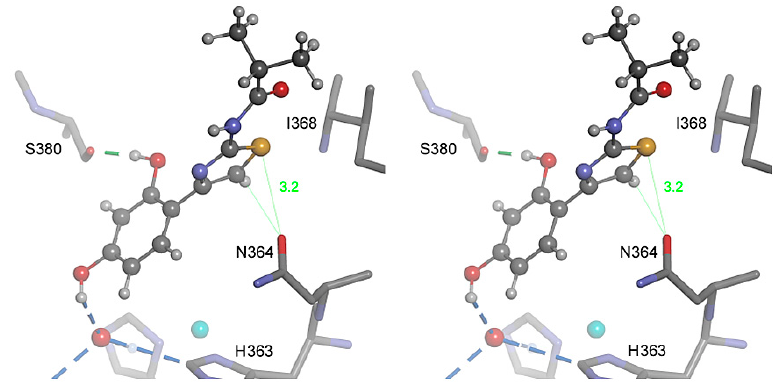
Figure 6. Proposed “sulfur bonding” interaction between the thiazole ring and Asn364 (stereo representation). The inhibitor W630 is shown in ball-and-stick representation, adjacent amino acid residues as sticks. The underlying structure is the same as shown in Figure 4a. For details, see text.